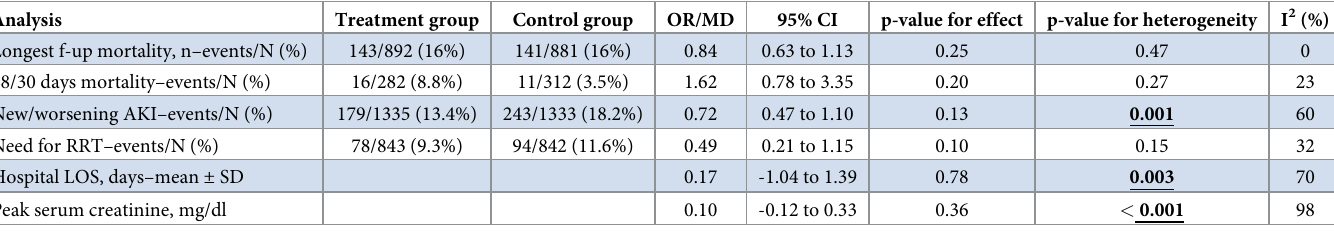
Table 2. Overall